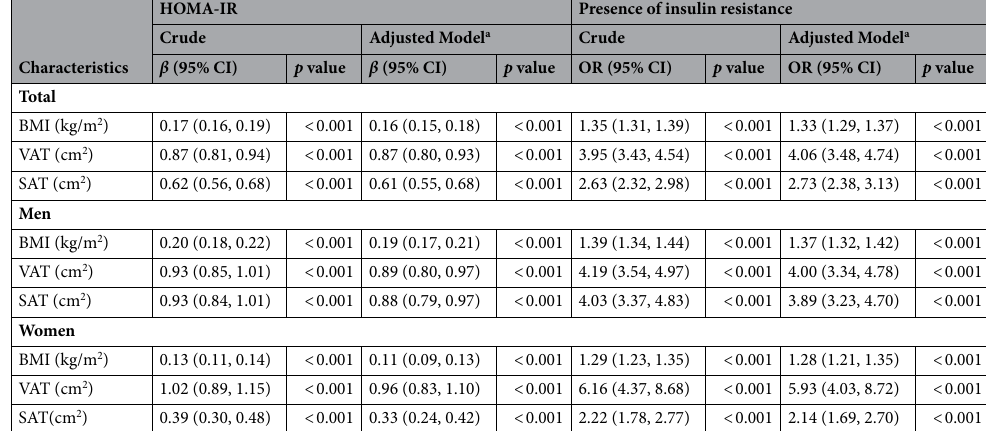
Table 2. Results of the regression analysis of the associations between HOMA-IR or the presence of insulin resistance and obesity traits. HOMA-IR homeostasis model assessment of insulin resistance index, BMI body mass index, VAT visceral adipose tissue, SAT subcutaneous adipose tissue, OR odds ratio, CI confidence interval. The beta coefficients, ORs, and 95% CIs for VAT and SAT areas were scaled to 100 cm 2 . a Adjusted model included age, smoking status (never, former, or current smoking), alcohol consumption (never, former, or current consumption), regular physical activity (yes or no), hypertension, and dyslipidemia as